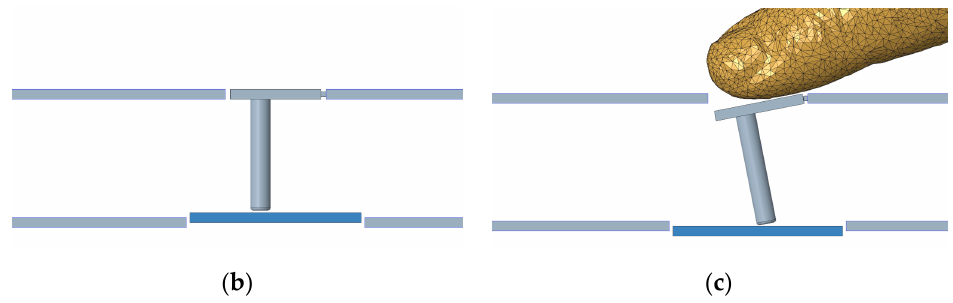
Figure 3. Design of the additional buttons in the casing compatible with the manual operation of the original button panel: ( a ) front view of a cantilever ‐ like button; ( b ) top view of the cantilever ‐ like button and of the original button (blue part); ( c ) top view representation of the effect of a finger pressing one of the additional buttons.